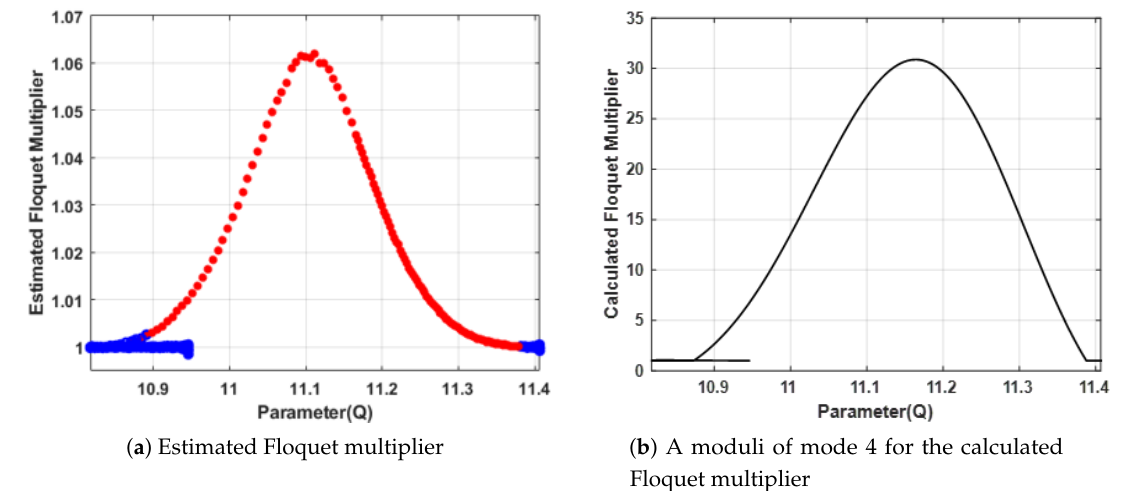
Figure 10. Floquet multiplier verification for the sample power system.